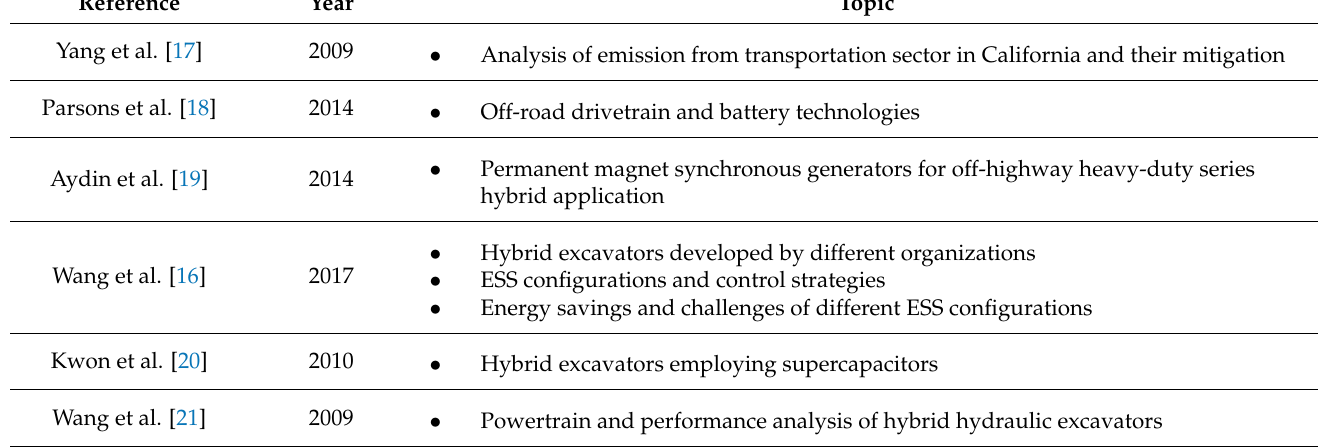
Table 1. Examples of previous works on off-road construction and agricultural equipment